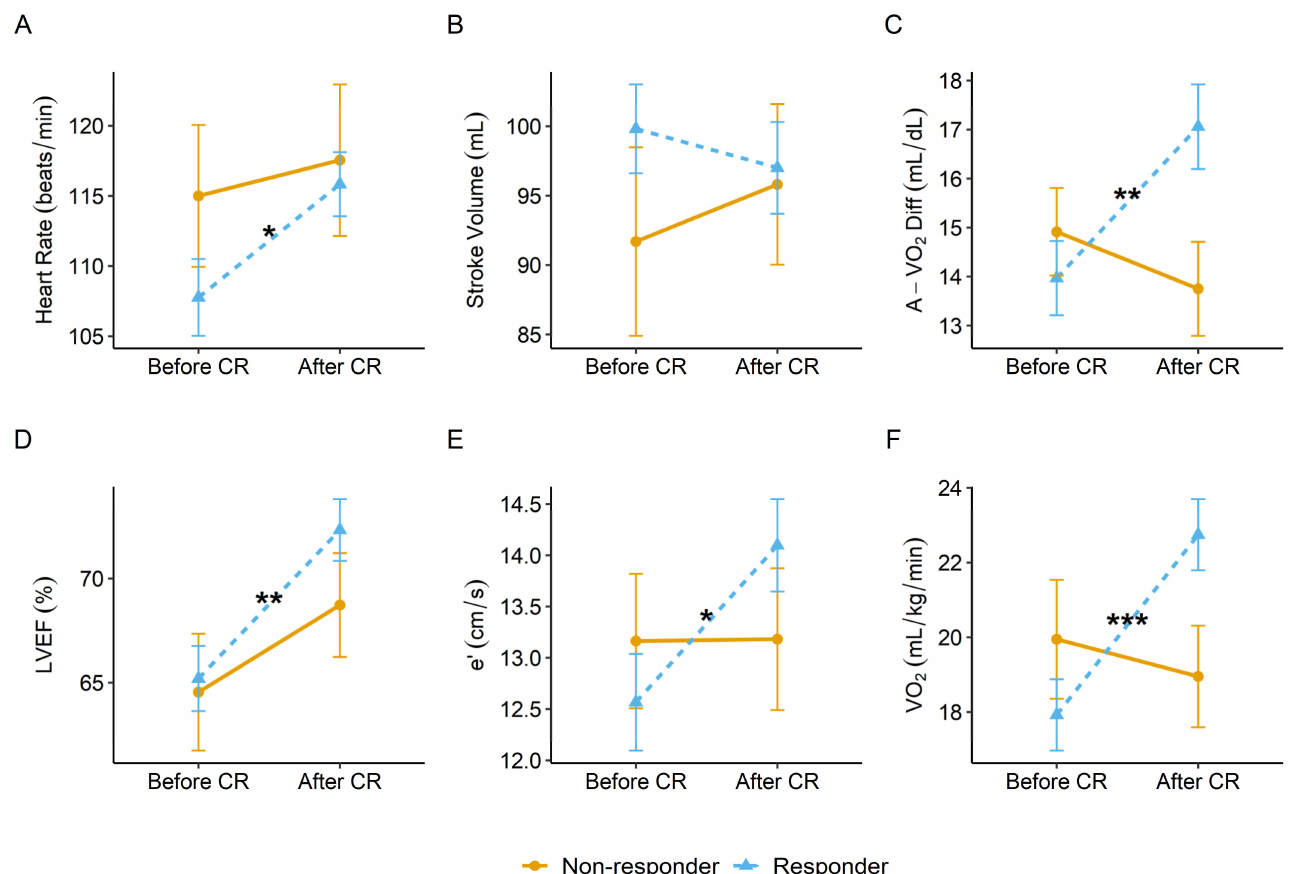
Figure 1. Peak exercise data before and after cardiac rehabilitation (CR) in responder and non-responder group for ( A ) heart rate, ( B ) stroke volume, ( C ) arteriovenous oxygen difference (A-VO 2 Diff), ( D ) left ventricular ejection fraction (LVEF), ( E ) early diastolic myocardial velocity (e’), and ( F ) oxygen uptake (VO 2 ). Error bars represent standard error of the sample. * p = 0.03, ** p < 0.01, *** p <